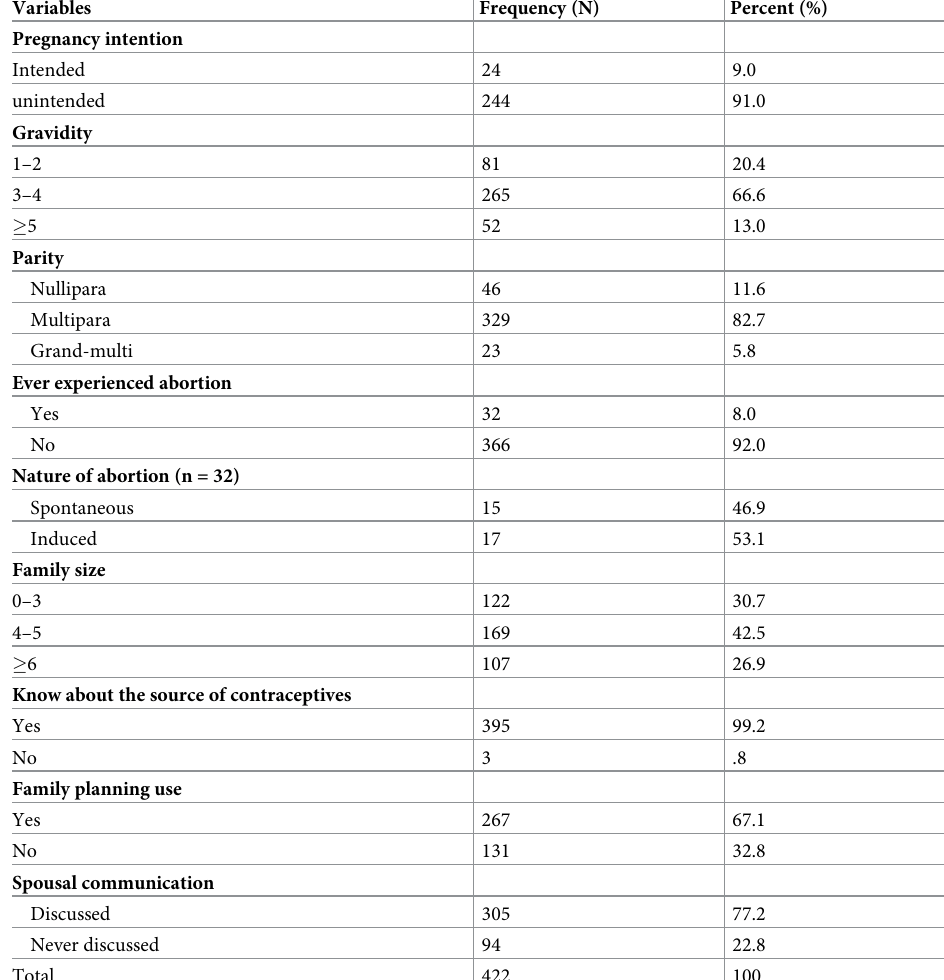
Table 2. Reproductive characteristics of women in Addis Zemen primary hospital, North-western Ethiopia, 2018 (n = 398). Variables Frequency (N) Percent (%) Pregnancy intention